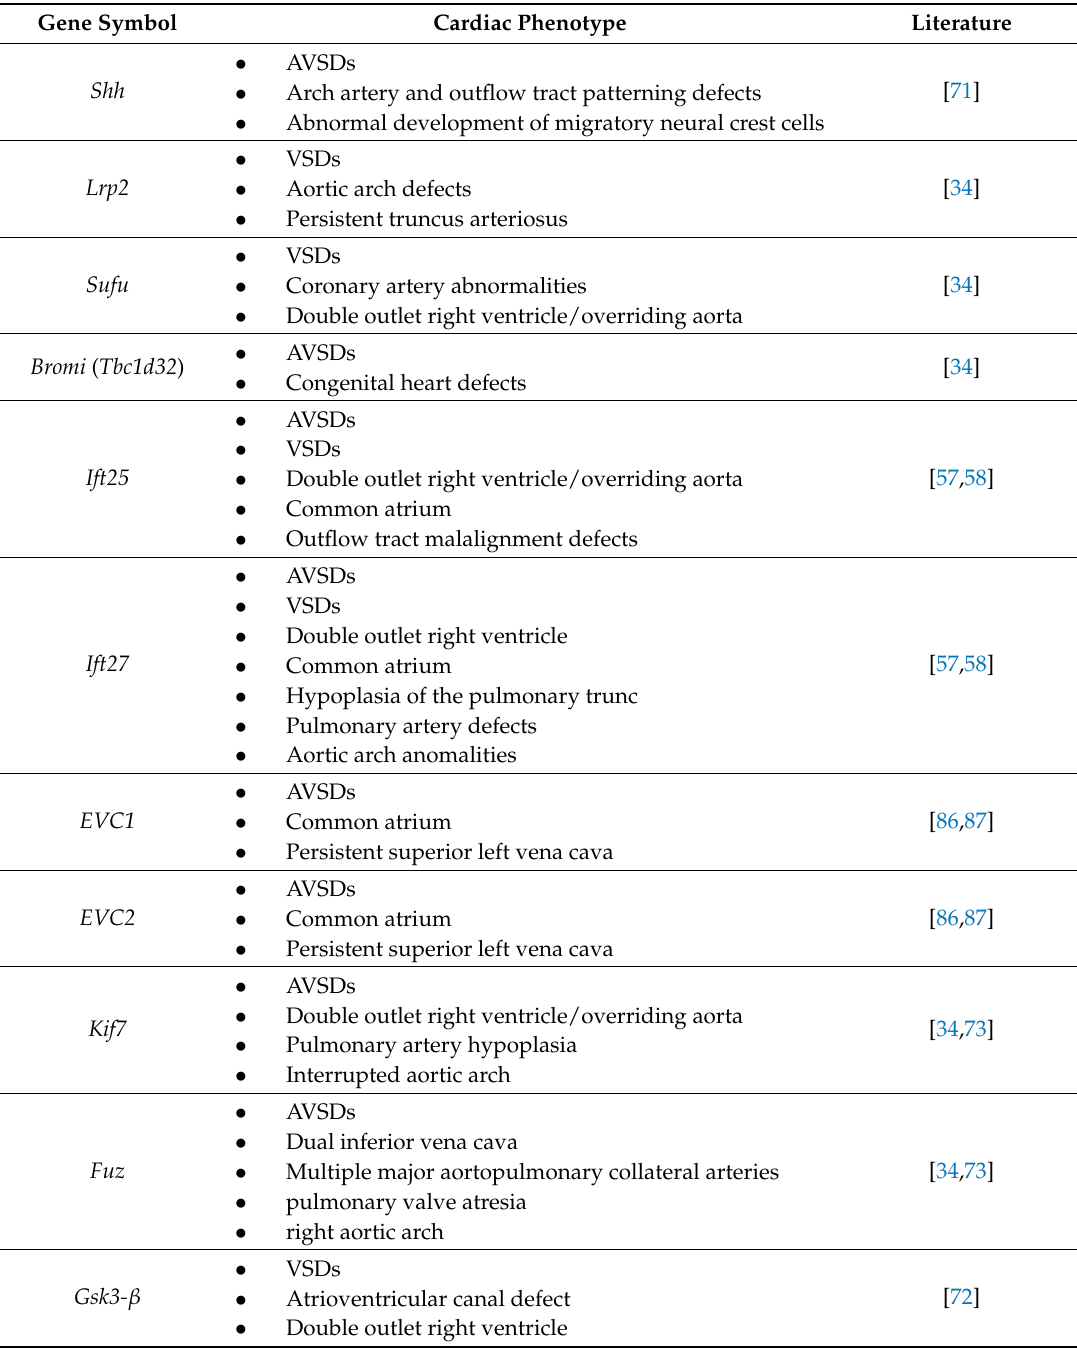
Table 1. Heart phenotypes of humans and mice mutant for genes encoding Hedgehog signalling